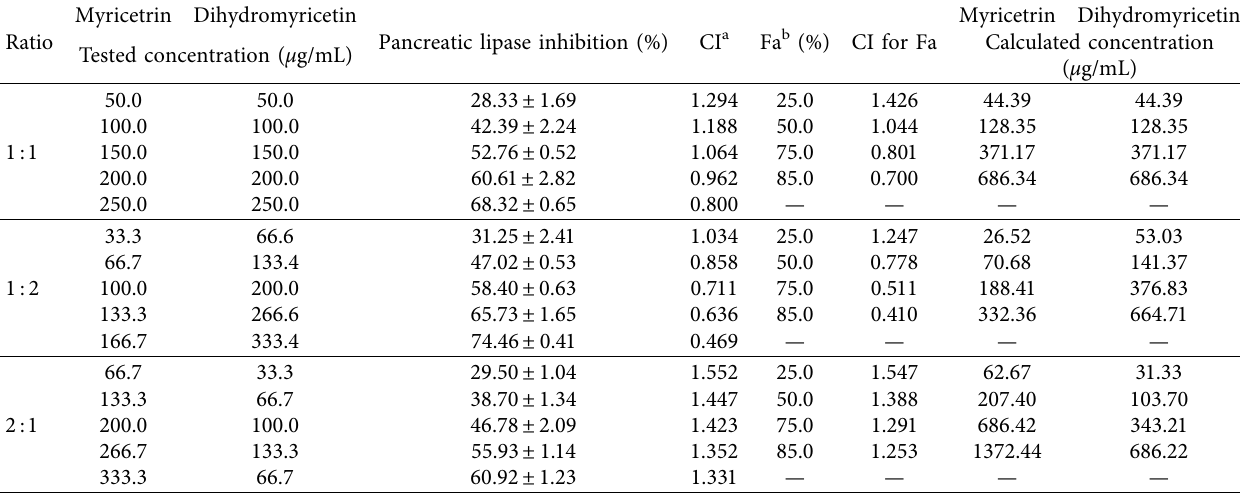
Table 2: Interaction between myricetrin and dihydromyricetin on pancreatic lipase inhibition. Myricetrin Ratio